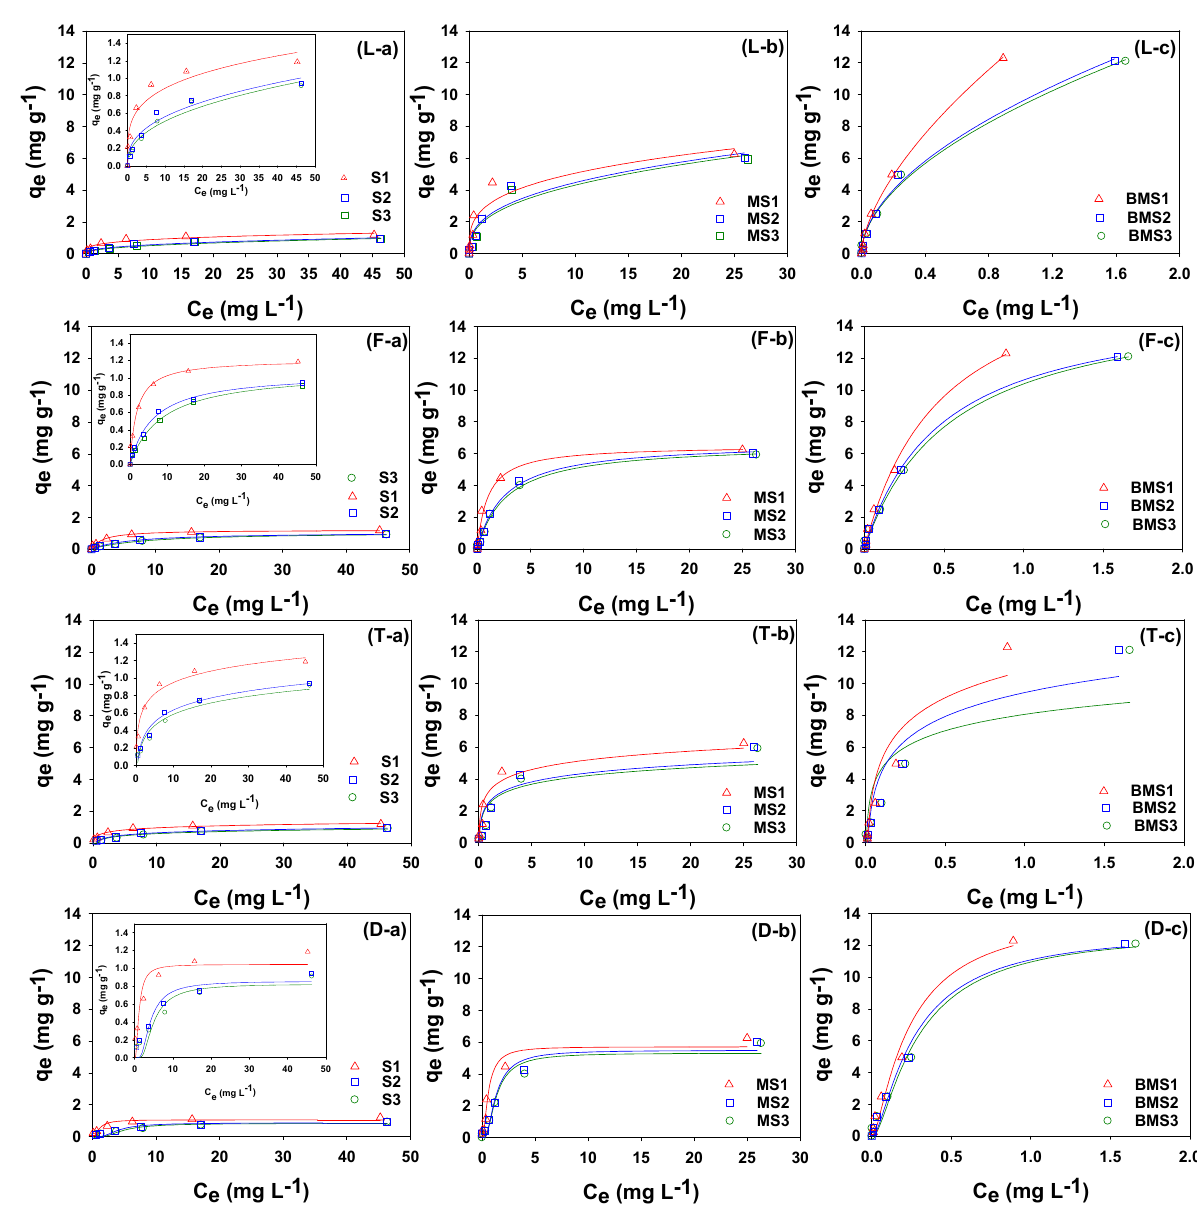
Figure 5. Doxycycline sorption fittings on Langmuir ( L-a , L-b , and L-c ), Freundlich ( F-a , F-b , and F-c ), Temkin ( T-a , T-b , and T-c ), and Dubinin–Radushkevich ( D-a , D-b , and D-c ) isotherm models by different soils (pH 7.41 (S1), pH 8.32 (S2), and pH 8.48 (S3)), manure + S1 (MS1), manure + S2 (MS2), manure + S3 (MS3), mesquite wood-waste-derived biochar + MS1 (BMS1), mesquite wood-waste-derived biochar + + MS2 (BMS2), and mesquite wood-waste-derived biochar + MS3 (BMS3).